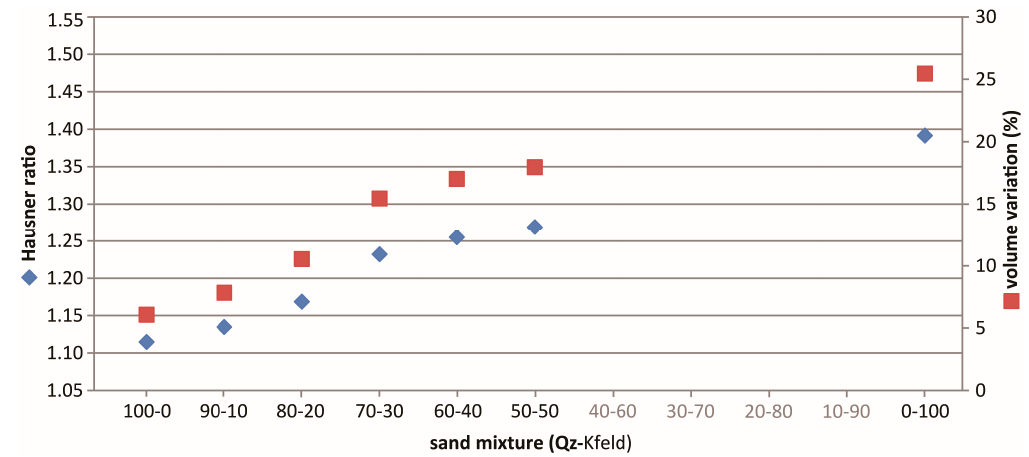
Figure 10. Variation of the Hausner ratio (blue dots) and the volume variation (red dots) as a function of the granular mixture composition.